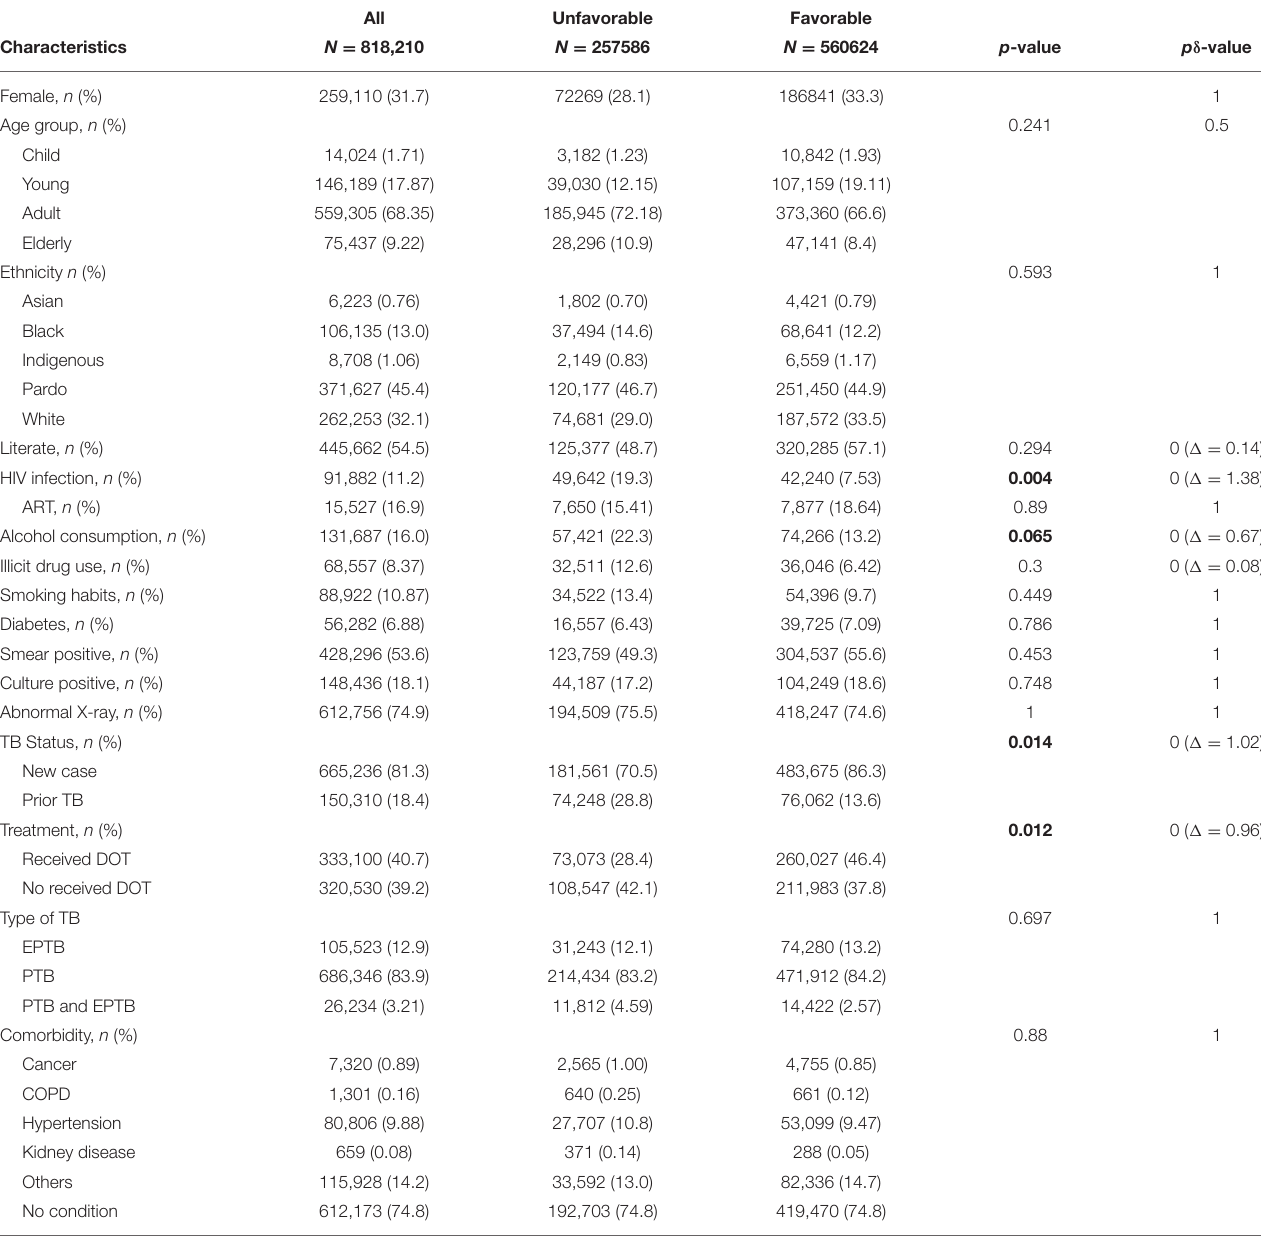
TABLE 3 | Population characteristics by categorical